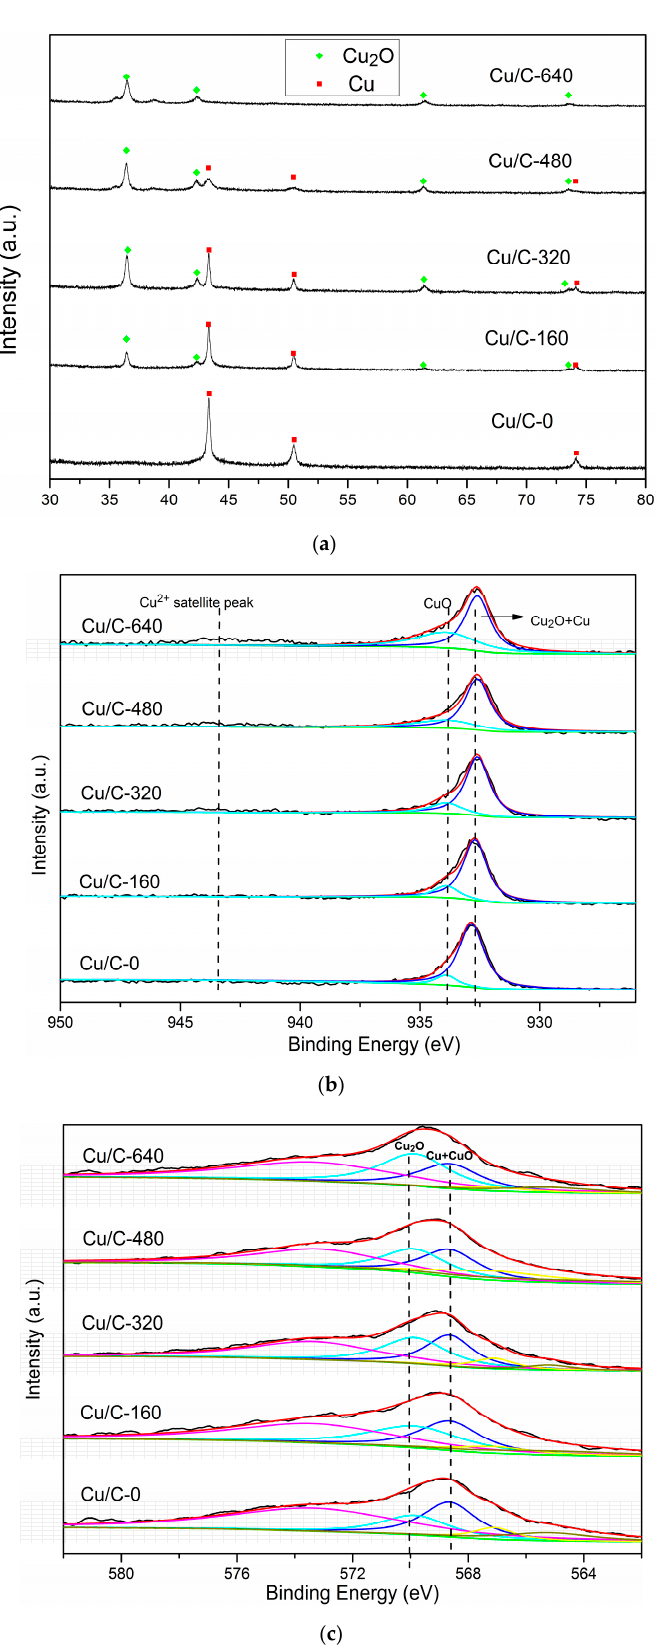
Figure 6. XRD patterns ( a ) XPS ( b ) and auger electron spectroscopy (AES) spectra ( c ) of Cu/C with different oxidation degrees.